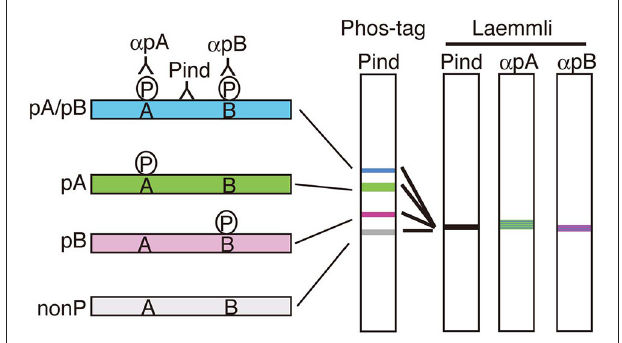
FIGURE 2 | Separation of phosphoisotypes of a protein on Phos-tag SDS-PAGE. If there are two phosphorylation sites, A and B, in a protein, there would be 4 phosphoisotypes, doubly phosphorylated (blue), two single site-phosphorylated (green and red) and nonphosphorylated (left). These four phosphoisotypes can be separated into four bands on Phos-tag SDS-PAGE by shifting upward differently depending on the number and site of phosphorylation (Phos-tag). Phospho-specific antibodies, α pA and α pB, are required to detect the respective phosphorylation in Laemmli’s SDS-PAGE, in contrast, the separation in Phos-tag indicates not only phosphorylation but also the degree of phosphorylation detected with a phosphorylation-independent antibody alone